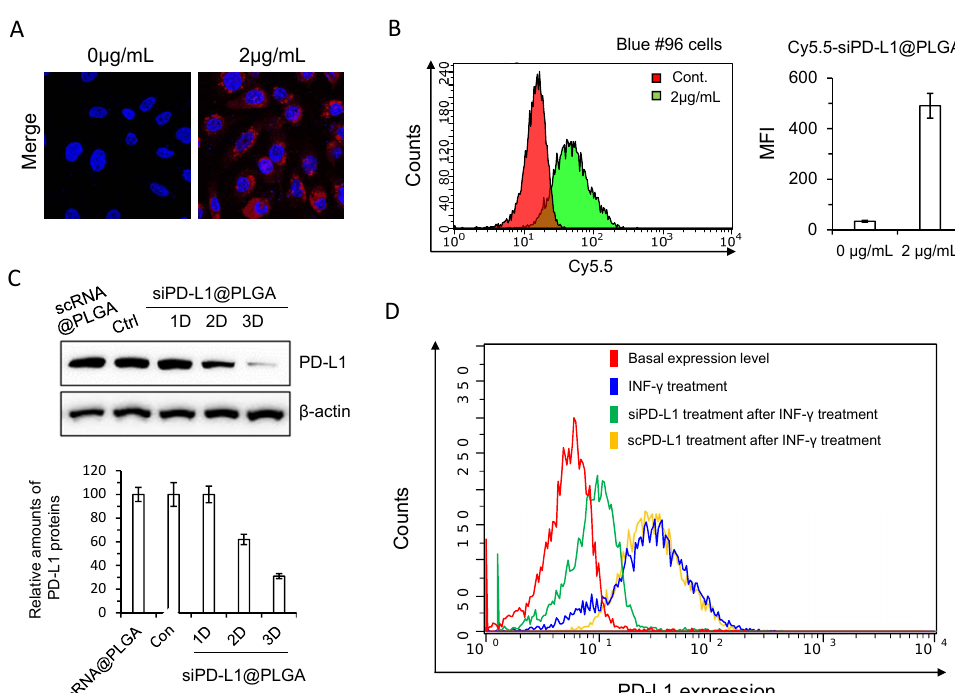
Figure 2. siPD-L1@PLGA efficiently enters and suppresses IFN-induced PD-L1 of PDAC cells. ( A ) Cellular uptake of Cy5.5-scRNA@PLGA NPs in the Blue #96 cells examined using confocal microscopic images. Cells were transfected with Cy5.5-scRNA@PLGA NPs for 4 h, and then their fluorescence images were measured. The nuclei were stained with DAPI dyes (blue). Red signals indicate Cy5.5-scRNA. The results are presented as the mean ± SD ( n = 3). ( B ) FACS histogram of Cy5.5-scRNA@PLGA-treated Blue #96 cells. Cells were transfected with Cy5.5-scRNA@PLGA NPs for 4 h and then analyzed against a prefixed gate region for Cy5.5 dyes. The results are presented as the mean ± SD ( n = 3). ( C ) Western blot images of Blue #96 cells after siPD-L1@PLGA NPs transfection. IFN- γ -stimulated Blue #96 cells were transfected with siPD-L1@PLGA NPs for 4 h and incubated for the indicated period. The PD-L1 protein levels were analyzed using the western blotting method. The control cells were IFN- γ -stimulated cells without transfection. The PD-L1 protein levels of the control cells and scRNA@PLGA-treated cells were measured 3 days after transfection. The relative protein levels of PD-L1 are plotted at the bottom. The results are presented as the mean ± SD ( n = 3). ( D ) FACS analysis indicated suppression of the PD-L1 expression on siPD-L1@PLGA-treated Blue #96 cells under IFN- γ stimulation. Cells were stimulated and transfected in a manner similar to that for Figure 1B. As a control, PD-L1 expression on scPD-L1@PLGA-treated Blue #96 cells under IFN- γ stimulation was